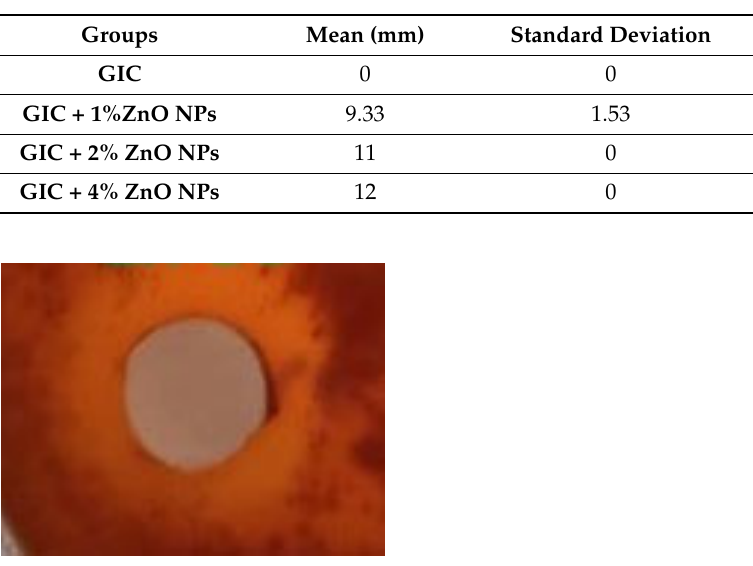
Figure 6. Inhibition zone of S. mutans bacteria for GIC containing ZnO NPs.